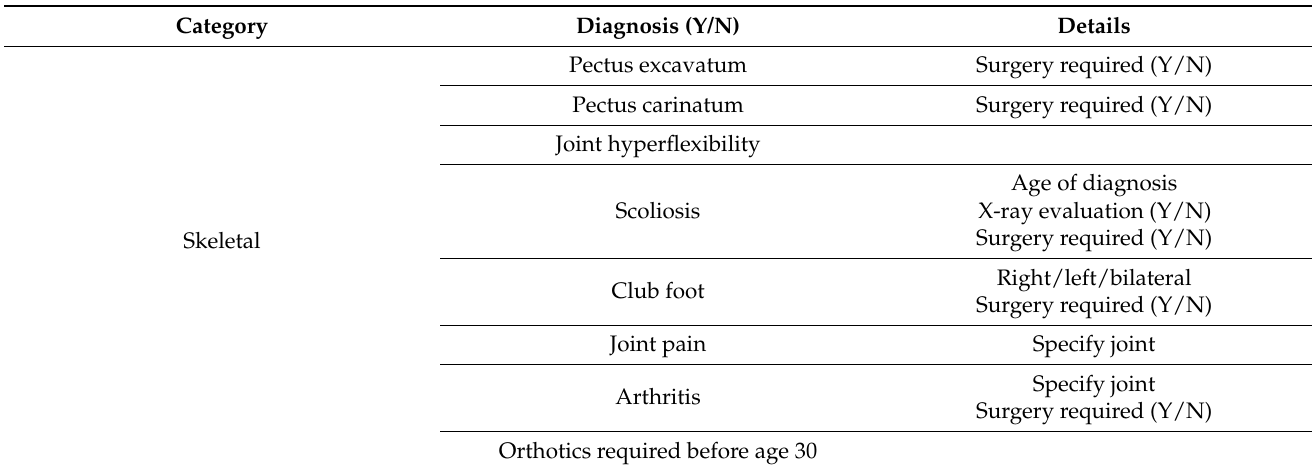
Table 3. Non-cardiovascular data collected through structured interviews and electronic medical record